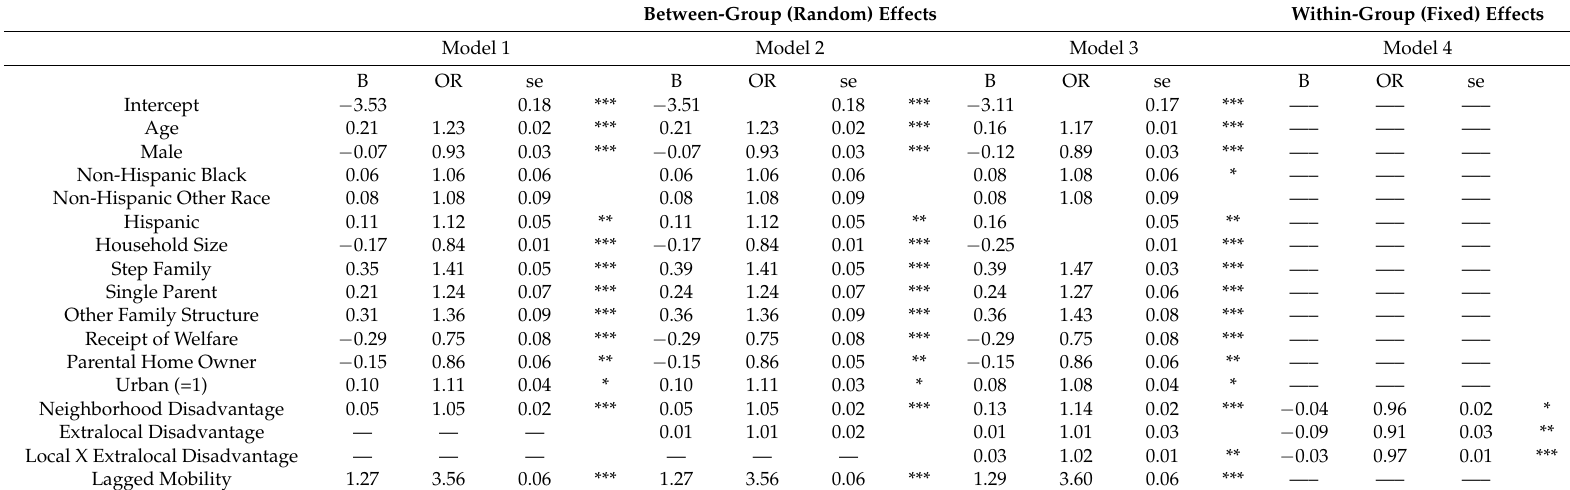
Table A3. Hybrid Random Effects Logistic Regression Estimates of Neighborhood Disadvantage, Extralocal Disadvantage, and Demographic Controls on Likelihood of Inter-tract Mobility (N =